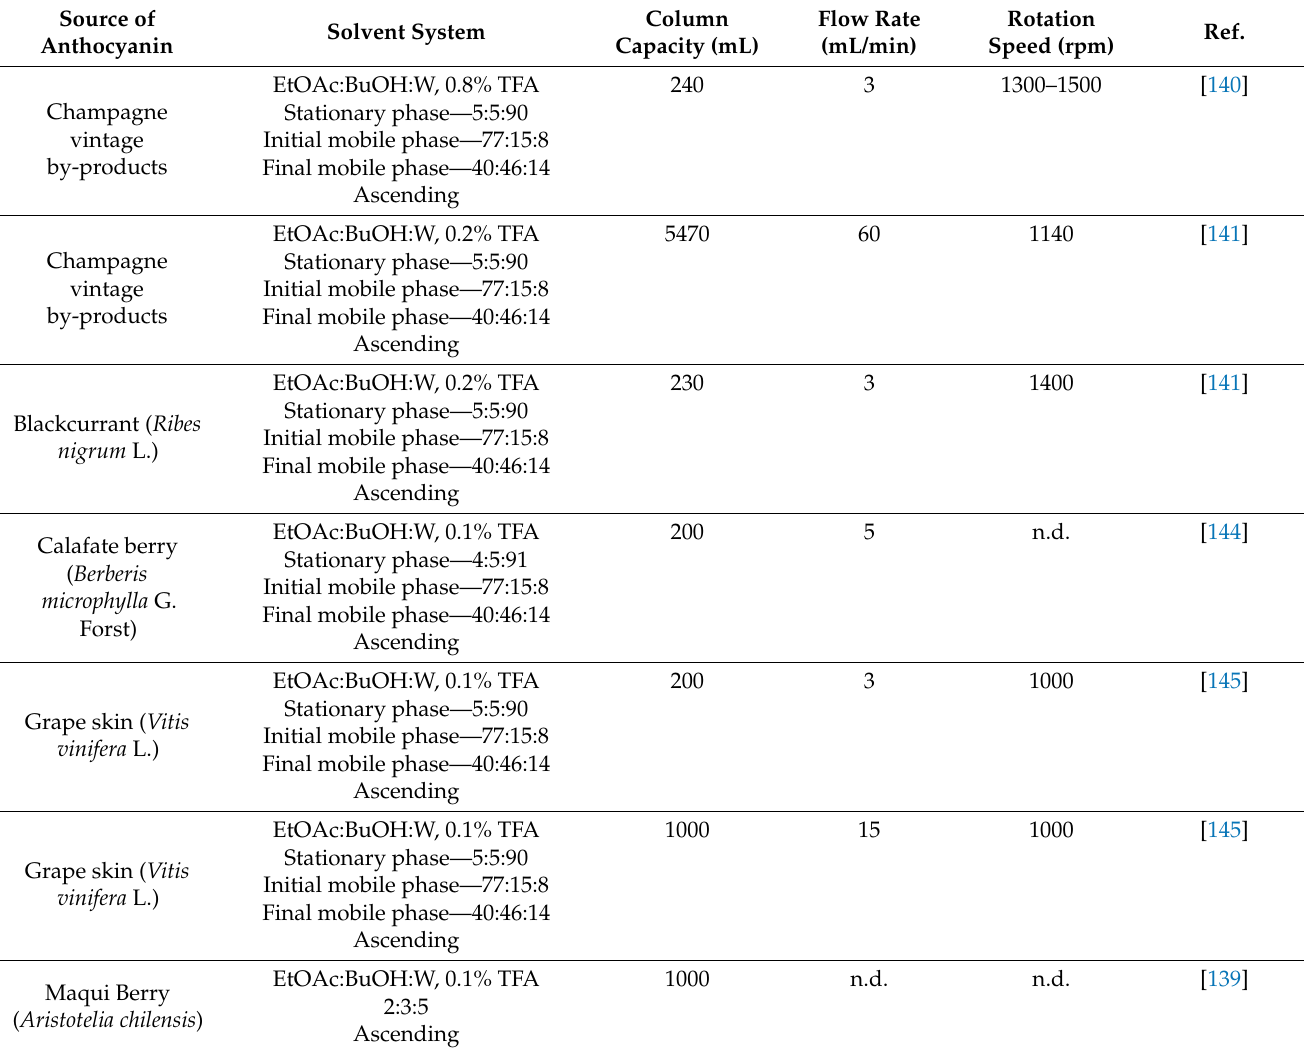
Table 3. Selected studies on separation of anthocyanins using counter-current chromatography (EtOAc: ethyl acetate; BuOH: n-butanol; W: water; TFA: trifluoroacetic acid; ACN: